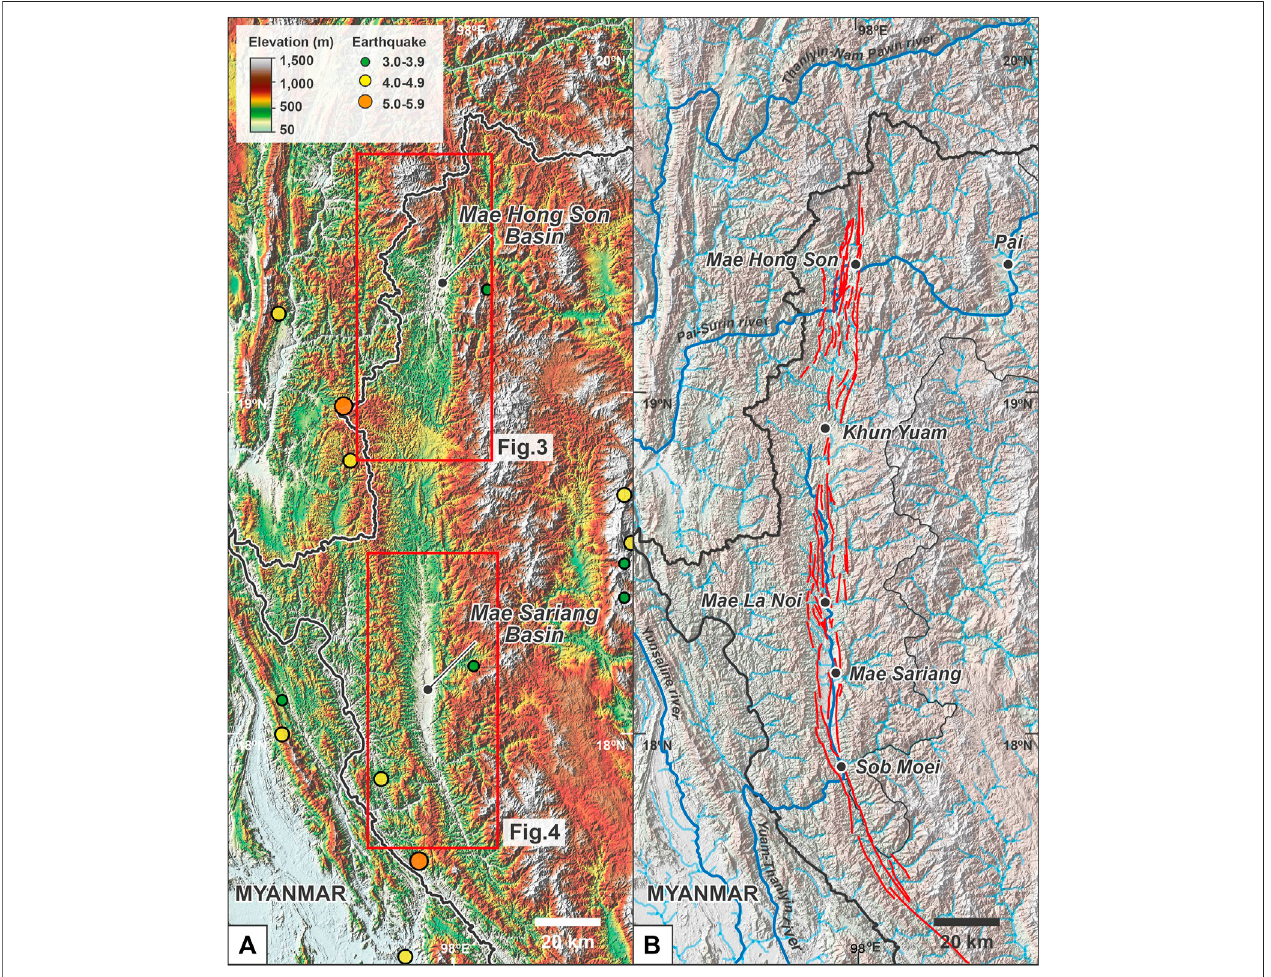
FIGURE2| Studyareashows: (A) enhancedALOSDEMdatahighlightingtheMaeHongSonBasininthenorthandtheMaeSariangBasininthesouthoftheMae Hong Son Province; and (B) hillshade ALOS DEM and stream maps highlight the north trending faultsegments throughout MaeHong Son Province. The red rectangles in part (A) highlight the geomorphic study areas shown in other fi gures.